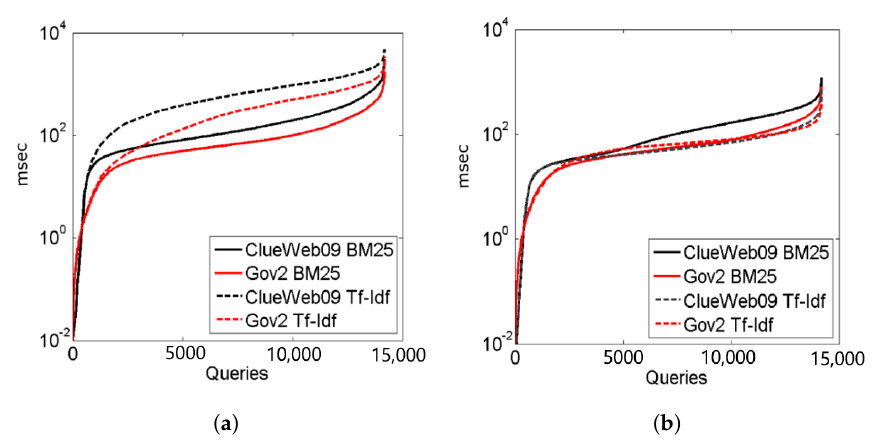
Figure 3. Running time of individual queries in milliseconds sorted from low to high values. ( a ) Results obtained with the WAND algorithm. ( b ) Results obtained with the BM-WAND